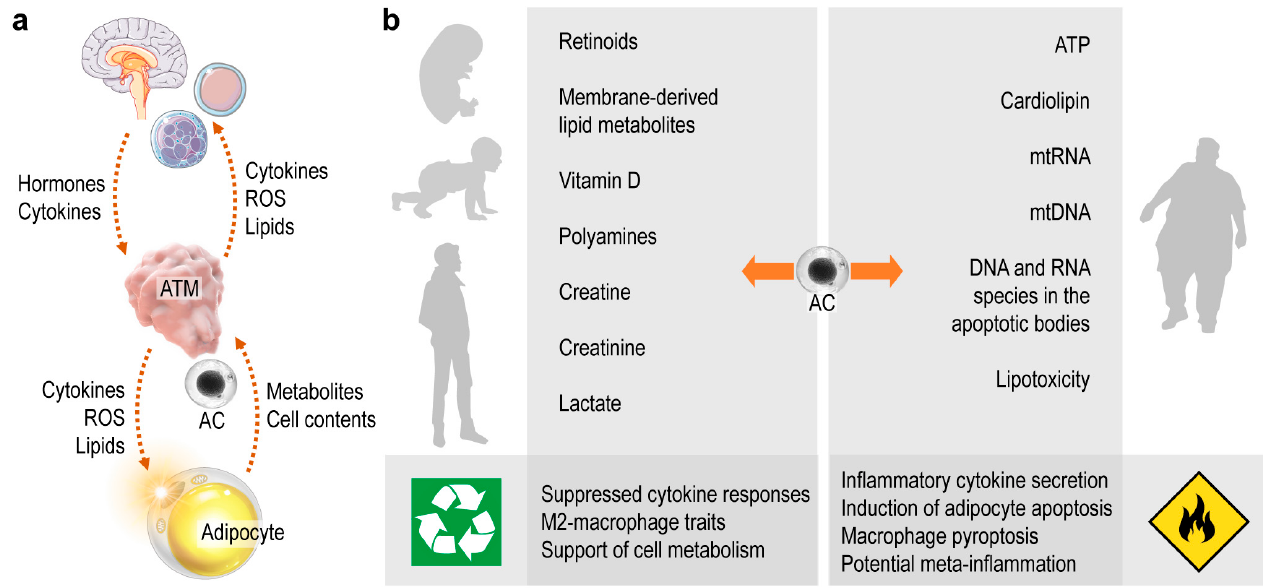
Figure 3. The two faces of apoptotic cell metabolites. ( a ) Chain of signaling events triggered by the apoptotic cell (AC). Metabolites and contents of the ACs are processed by ATMs. As a response, ATMs release cytokines, reactive oxygen species (ROS) and various lipid mediators, which signal to other immune cells, the central nervous system and the endocrine organs. In turn, these cells and organs release hormones, neurotransmitters and cytokines that shape ATM functions and, ultimately, determine the metabolic performance of the adipocytes. ( b ) Metabolites and contents of the dying adipocytes may be safely recycled by macrophages in an immunologically silent process, which results in gain of M2-macrophage traits and supports tissue turnover and metabolic health. Some contents of the apoptotic cells—especially of the dying adipocytes—deliver danger signals to the macrophages, and trigger inflammation and inflammatory cell death. Eventually the tissue integrity is impaired and immune-metabolic disease develops, such as meta-inflammation in the obese adipose